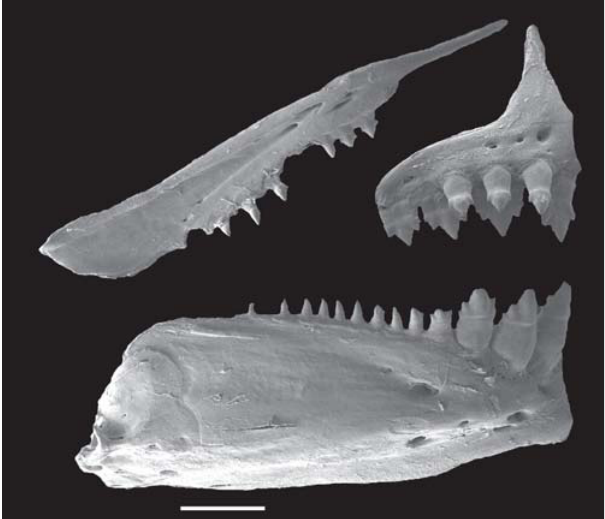
Fig. 9. Hemibrycon huambonicus , ROM 55406, male, 70.0 mm SL. Scanning electron micrograph of right side upper and lower jaws. Scale bar = 1